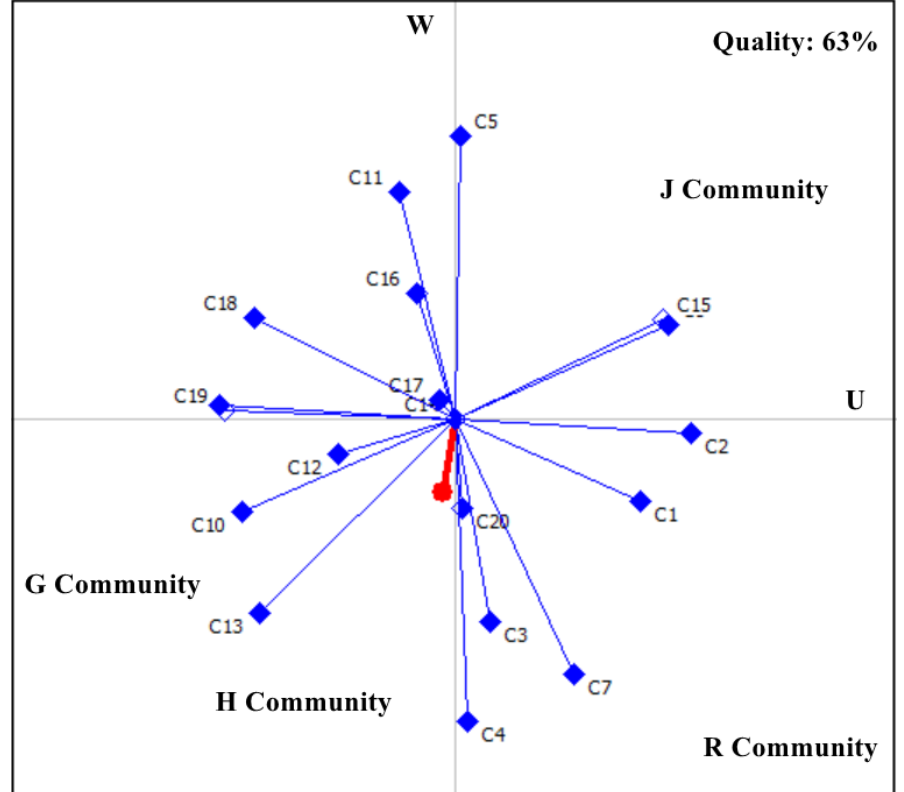
Figure 8. Graphical analysis for interactive aid with W-U coordinate systems.